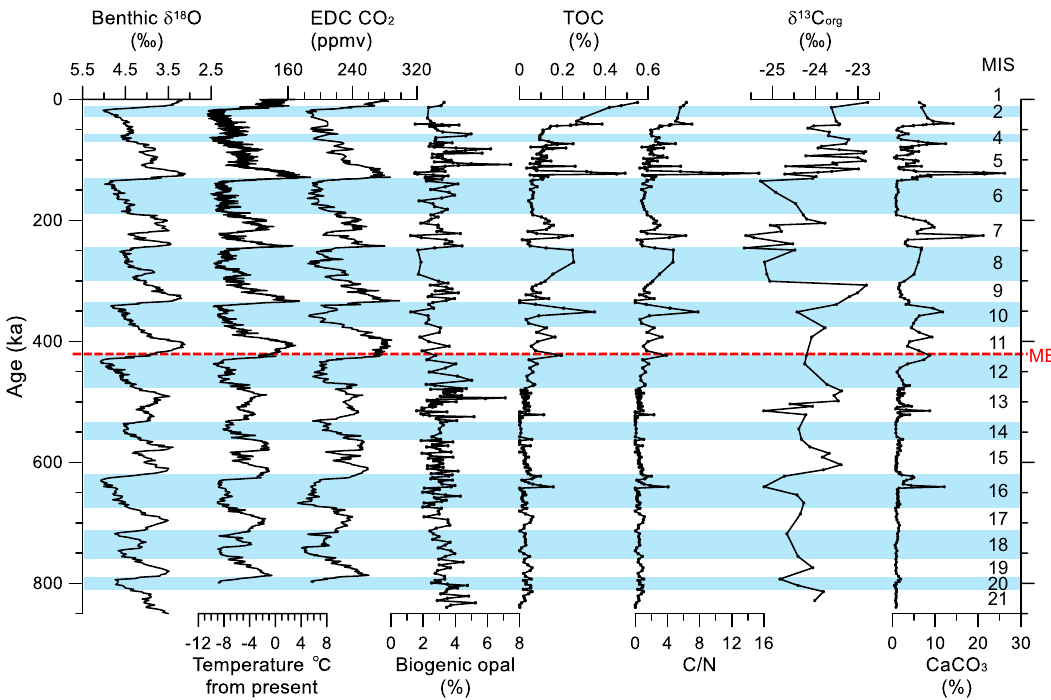
Figure 2. Downcore variation of geochemical results (biogenic opal, TOC, C/N, δ 13 C org , and CaCO 3 ) of core ARC5-MA01 along with global benthic δ 18 O values 1 and EPICA Dome C (EDC) records, including air temperature 4 and atmospheric CO 2 concentration 5 . Marine isotope stages (MIS) are indicated with blue shadings of glacial periods and white shadings for interglacial periods.